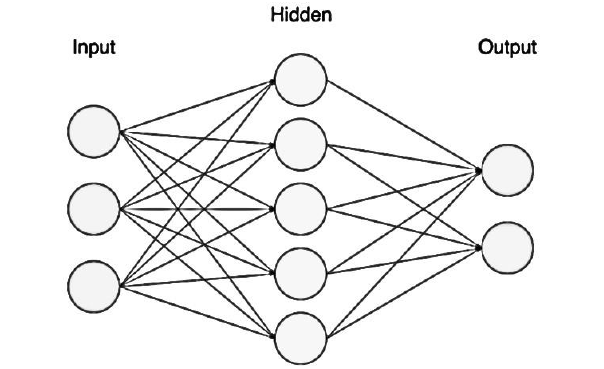
Figure 3 . Typical Artificial Neural Network